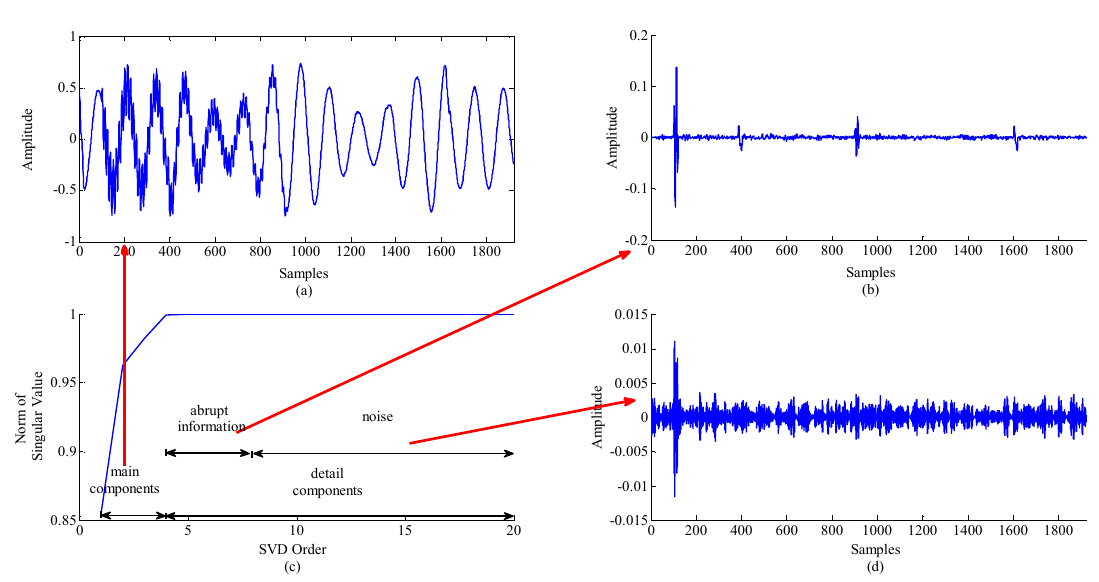
Figure 3. The schematic diagram of catastrophe points location. ( a ) The main components; ( b ) The abrupt information; ( c ) The norm of singular value; ( d ) The noise.